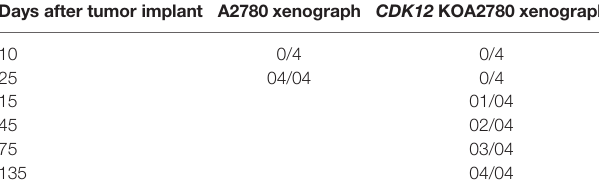
TABLE 1 | No of mice tumor/no of transplanted mice with A2780 and CDK12 KO A2780